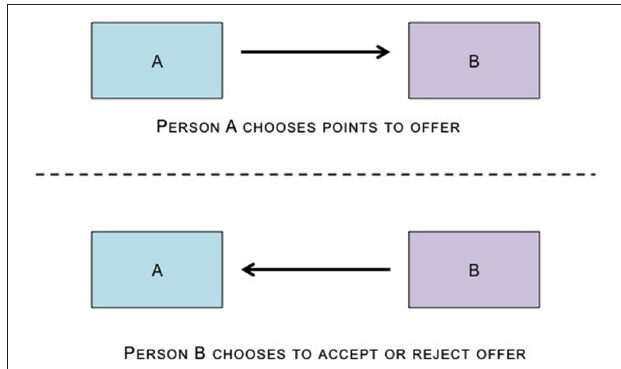
FIGURE 3 | The Ultimatum Game has two players. One player (the proposer) receives an amount of money and makes a proposal to the other player (the responder) regarding how to divide the money between them. If the responder accepts the proposed split, both players receive the allocated money. However, unlike the DG, the responder has the option to reject the proposed split, leading both players to receive nothing.